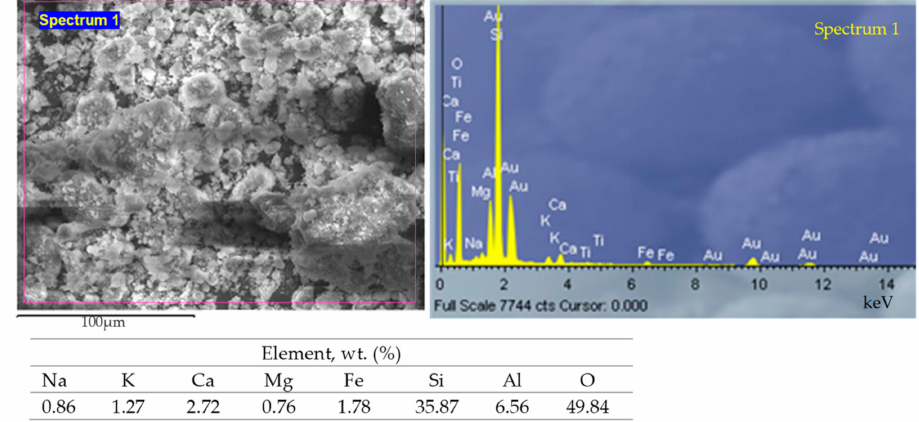
Figure 13. SEM image and EDS analysis with mass percentage values of the detected elements on the marked (Spectrum 1) surface for raw natural